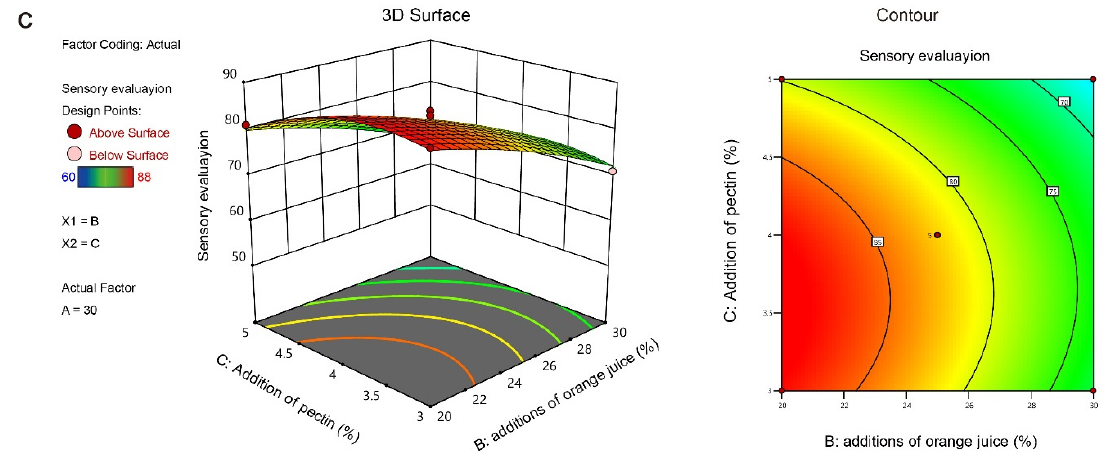
Figure 2. Response surface plots showing the effect of the chenpi decoction with orange juice ( a ), chenpi decoction with pectin ( b ), and orange juice with pectin ( c ) on the sensory evaluation.